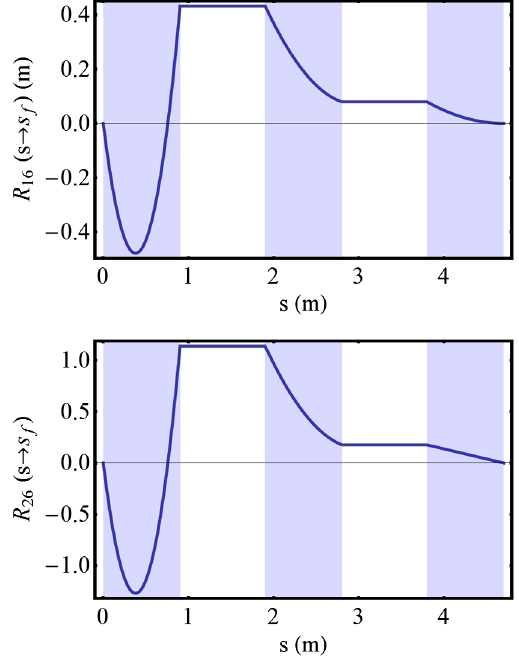
s → s f R s → s f FIG. 3. Functions R 16 and 26 for the optimum value m ¼ 15 = 2 L 21 B . The shaded areas highlight the dipoles. For better illustration, we shortened the length of the sections between the dipoles (where these functions are constant) to 1 m compared to Fig. 3. The sum of the integrals of the two curves within the shaded area vanish [see Eq. (14) and (15)] resulting into no projected emittance growth from CSR.